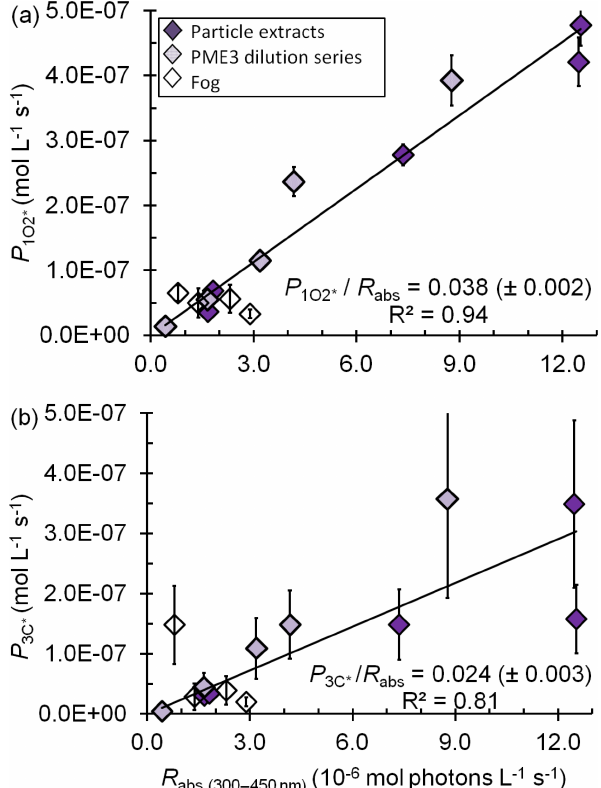
Figure 3. Correlations between (a) the rate of singlet oxygen pho- toproduction normalized to Davis winter-solstice sunlight ( P 1 ), O 2 ∗ (b) the rate of triplet photoproduction normalized to Davis winter- solstice sunlight ( P 3 ), and the rate of light absorption ( R abs ) be- C ∗ tween 300 and 450nm. Triplet rates for the fog samples were ad- justed to account for the small DOC sink for triplets (Eq. 8). The P/R abs ratios ( ± 1SE) listed are unitless and represent the quan- tum